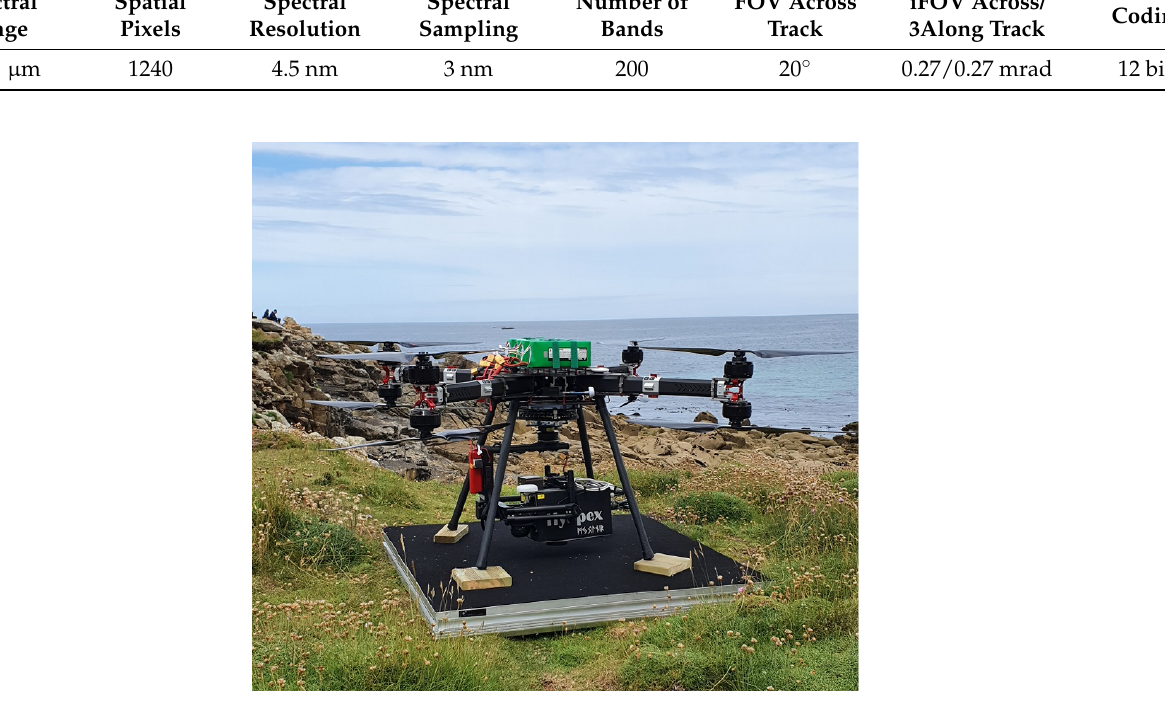
Figure 2. UAV octocopter used for the acquisitions.